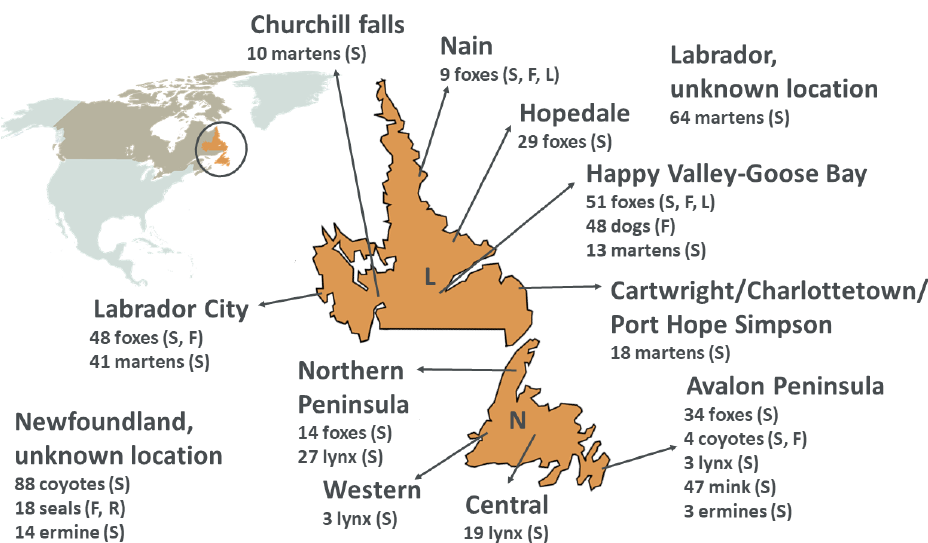
Figure 1. Locations of sample collection. The map on the top-left shows the province of Newfoundland and Labrador (included in the circle) within North America and Canada (brown), while Labrador (L) and the island of Newfoundland (N) are showed enlarged in the middle. For each location, the list of species and the number of investigated animals for each species are given together with the type of available samples (S: spleen; F: fecal; L: lymph node; R: respiratory). Map was created with Mapchart.net © (accessed on 28 September 2021). Foxes ( n = 50), lynx, mink, ermines, and coyotes were sampled in Newfoundland, while fox ( n = 137), marten, and dog samples originated from Labrador. Seals